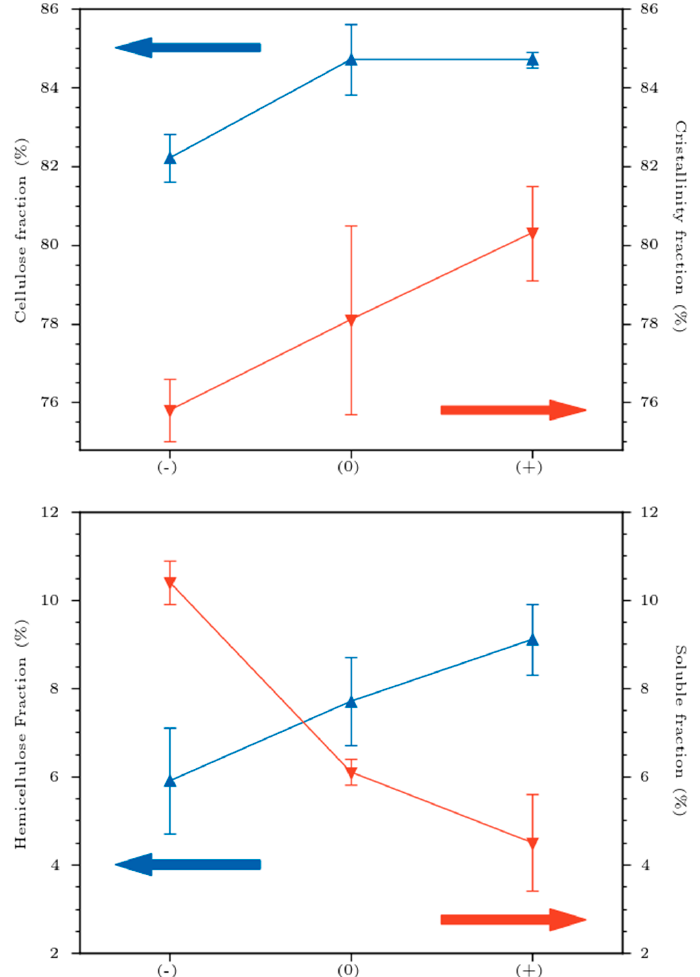
Figure 8. Biochemical fractions (cellulose, hemicellulose, solubles) and crystallinity variations in technical flax fibers. Red and blue arrows indicate the axis for red and blue line.